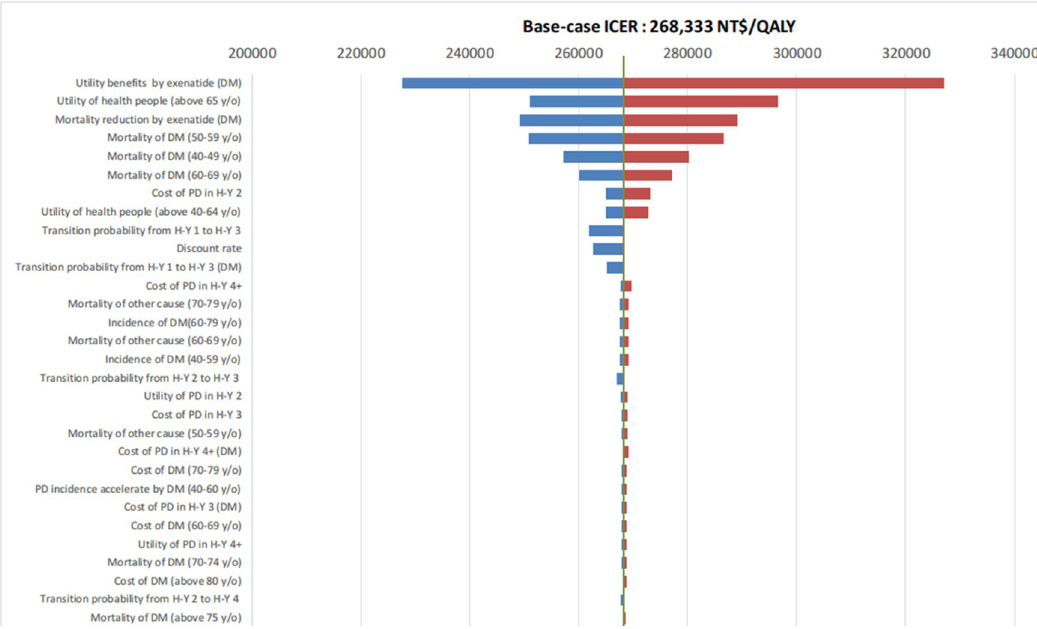
Fig 3. Tornado plot of the one-way sensitivity analysis of all input parameters of the cost-effectiveness analysis comparing conventional pharmacotherapy + exenatide with conventional pharmacotherapy in PD with DM.